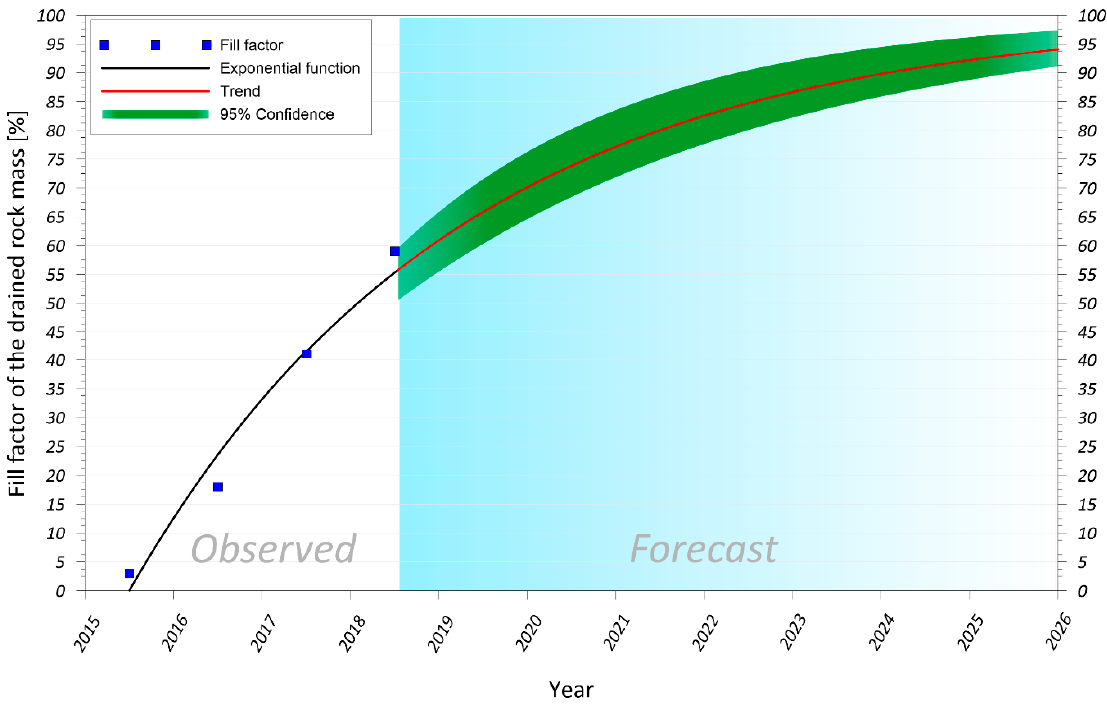
Figure 8. Time function of the fill factor of the drained rock mass in the flooded Lubichów mine.